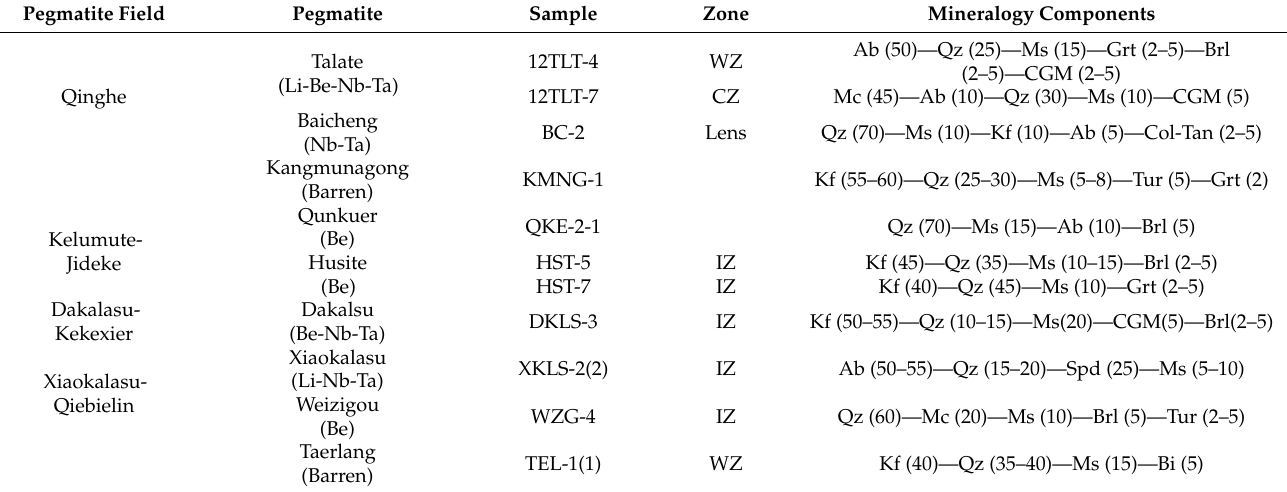
Table 2. Descriptions of the studied samples in the Chinese Altai.